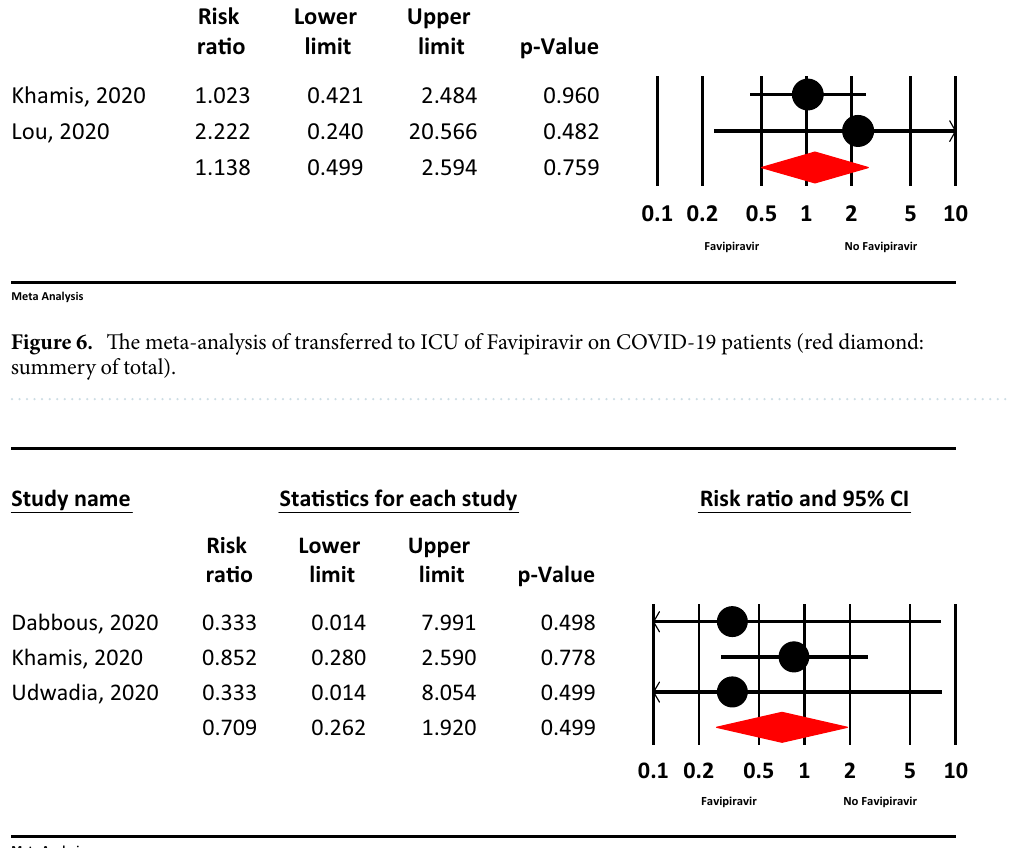
Figure 7. The meta-analysis of mortality of Favipiravir on COVID-19 patients (red diamond: summery of